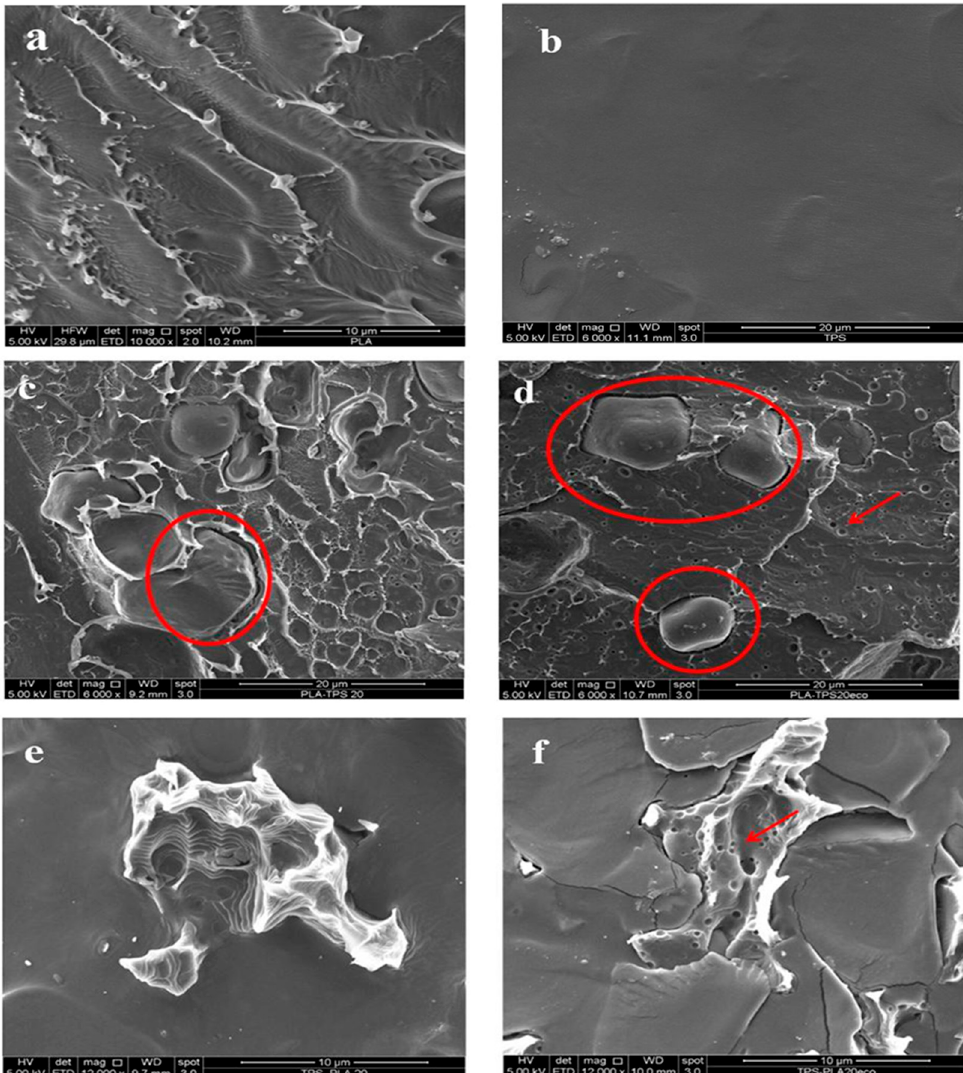
Figure 3. Cross-sectional surface SEM micrographs of neat PLA ( a ), neat TPS ( b ), PLA80 ( c ), PLA80_ECO ( d ), TPS80 ( e ), and TPS80_ECO ( f ), respectively.